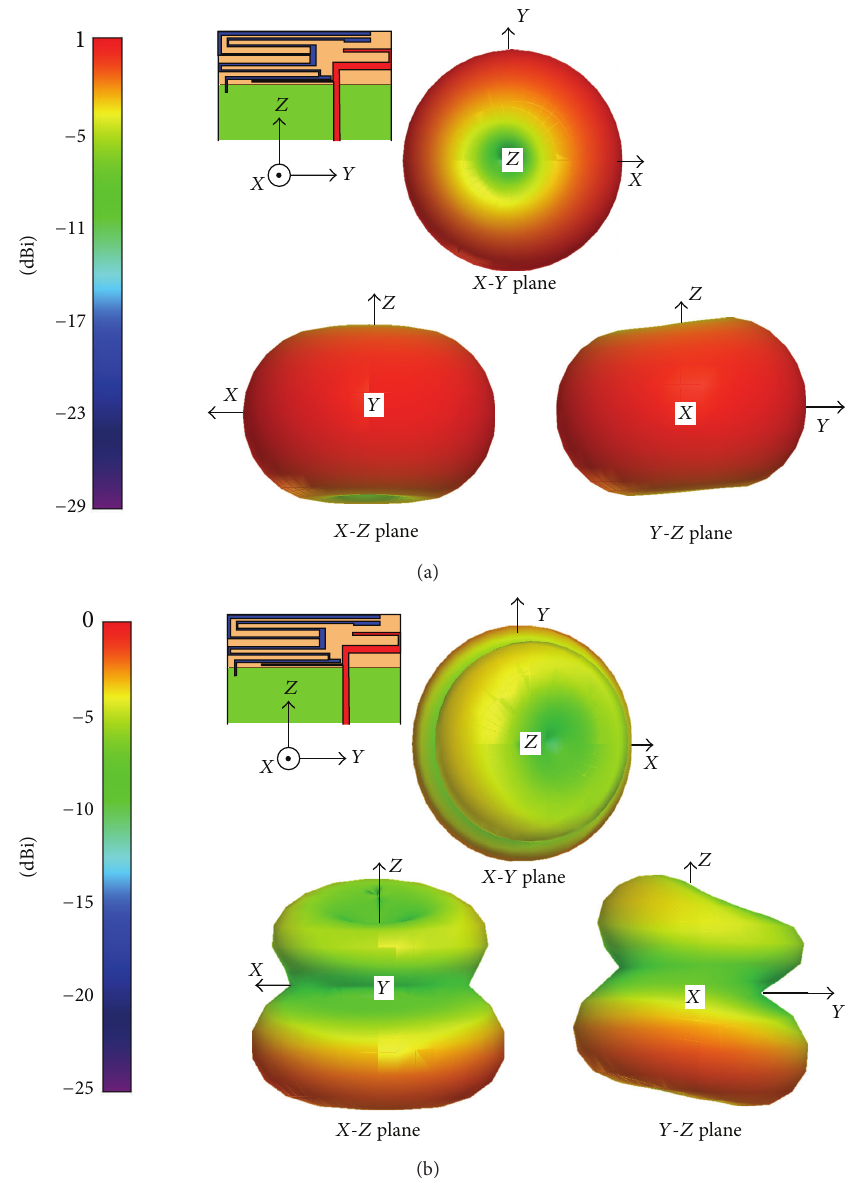
Figure 9: Simulated three-dimensional radiation pattern at (a) 750 MHz and (b) 2500